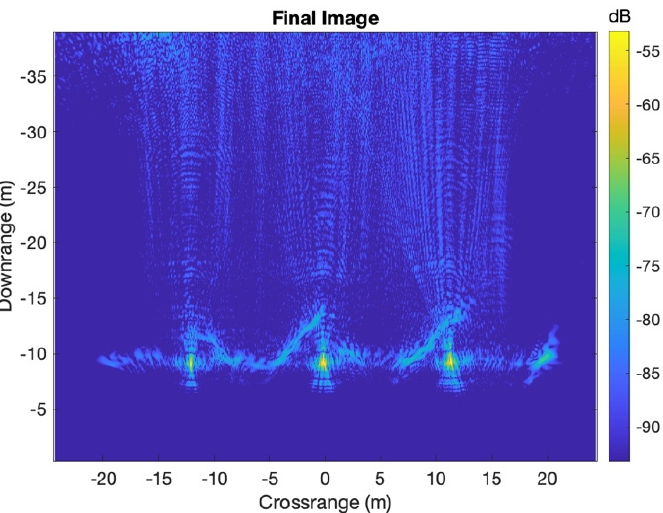
Figure 9. Radar image after